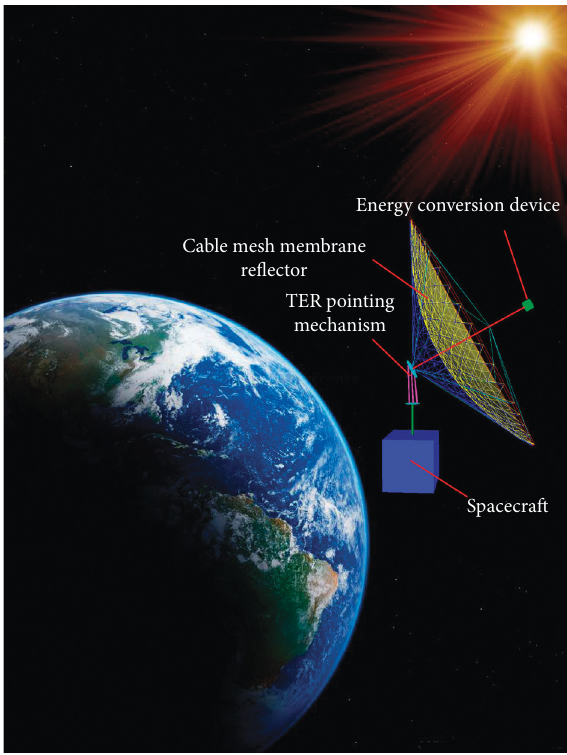
Figure 1: Schematic of the